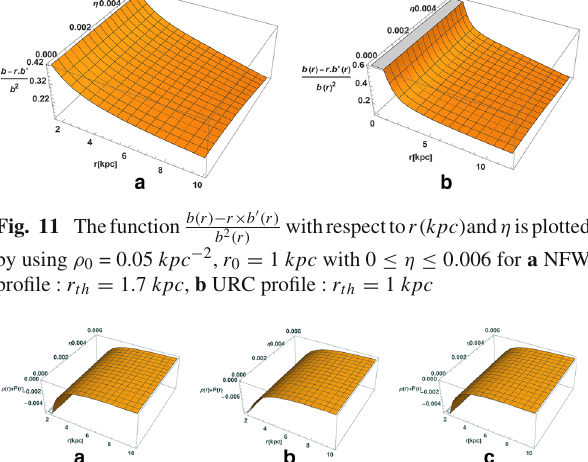
Fig. 8 Full visualization of wormhole structure for a NFW profile : r th = 1 . 7 kpc , b Pseudo-Isothermal profile : r th = 1 kpc , c URC profile : r th = 1 . 1 kpc